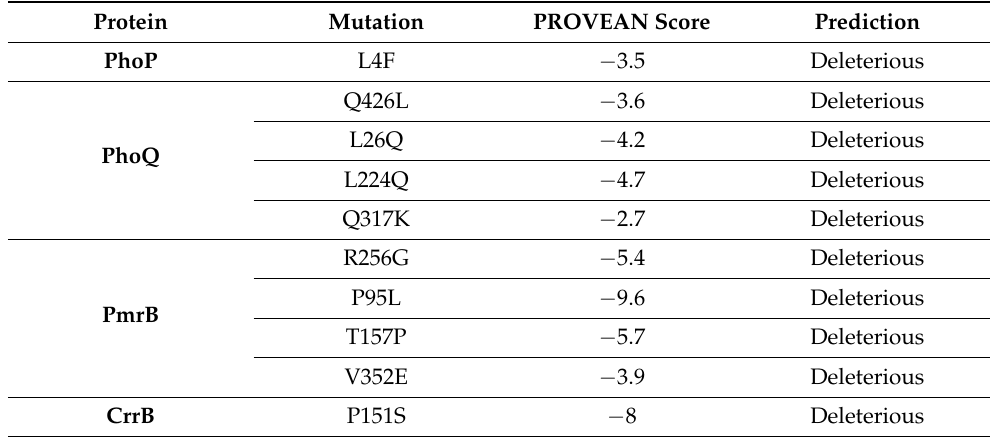
Table 6. PROVEAN prediction for all possible deleterious amino acid substitutions detected in PhoP, PhoQ, PmrB, and CrrB proteins. Protein Mutation PROVEAN